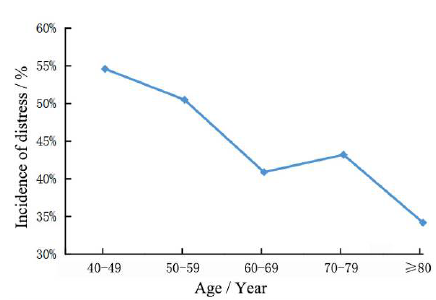
Figure 6. Variation trend of distress of middle-aged and elderly